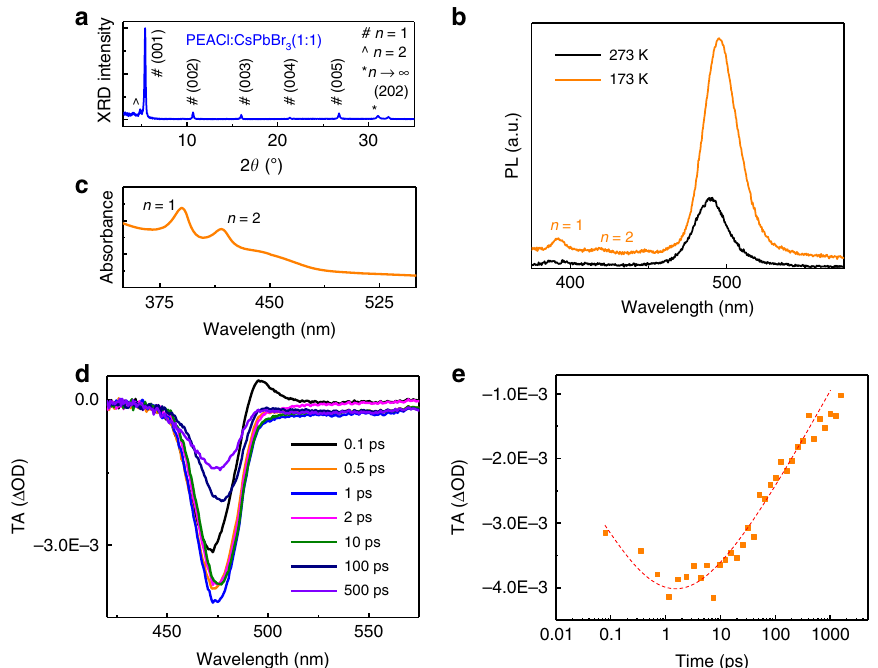
Fig. 3 Phase composition study of CsPbBr 3 :PEACl (1:1) fi lm and the function of layered phases. a XRD of CsPbBr 3 :PEACl (1:1) fi lm. b PL spectra of CsPbBr 3 :PEACl (1:1) fi lm at 273 K and 173 K. c Absorbance of CsPbBr 3 :PEACl (1:1) fi lm. d Transient absorption (TA) spectra of CsPbBr 3 :PEACl (1:1) fi lm at different timescales. e TA signal measured at a probe wavelength of 480 nm reveals distinct bleaching of the 3D phase in the CsPbBr 3 :PEACL (1:1) fi